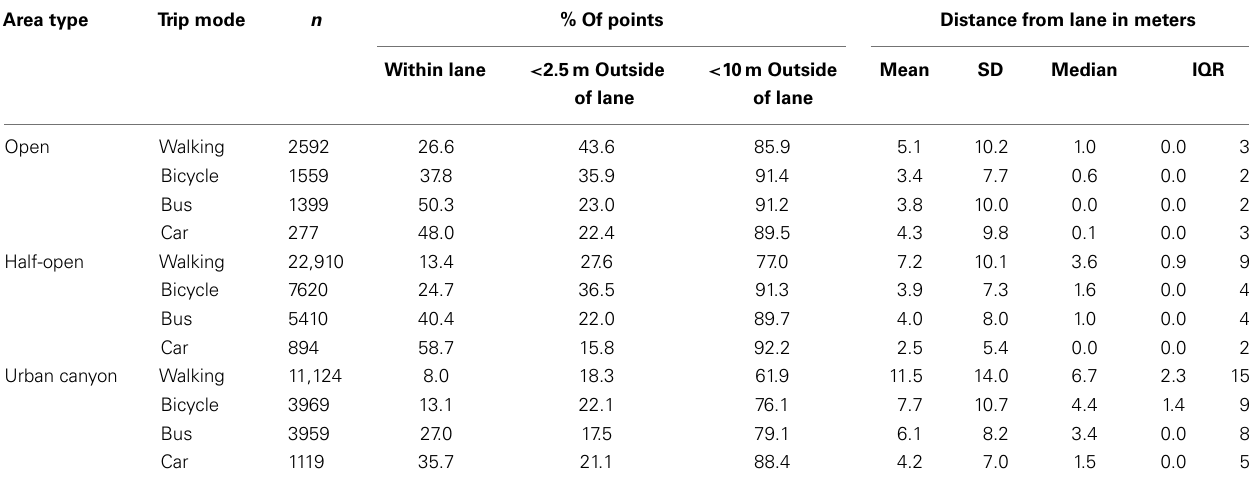
Table 2 | Dynamic spatial accuracy in percent of points and mean and median errors in meters, for four modes of transport within three area types